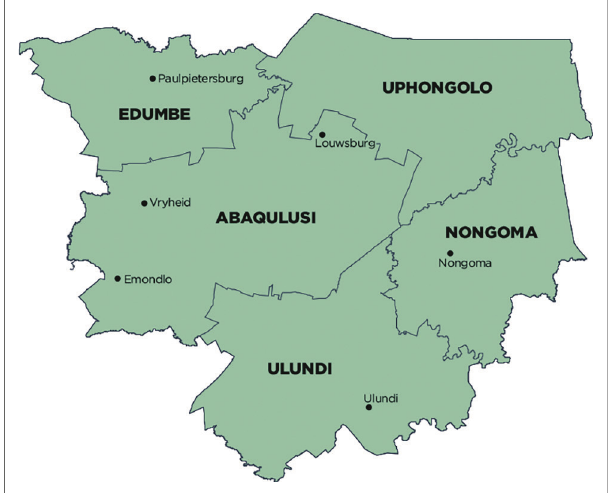
FIGURE 3 : Education levels of the respondents.